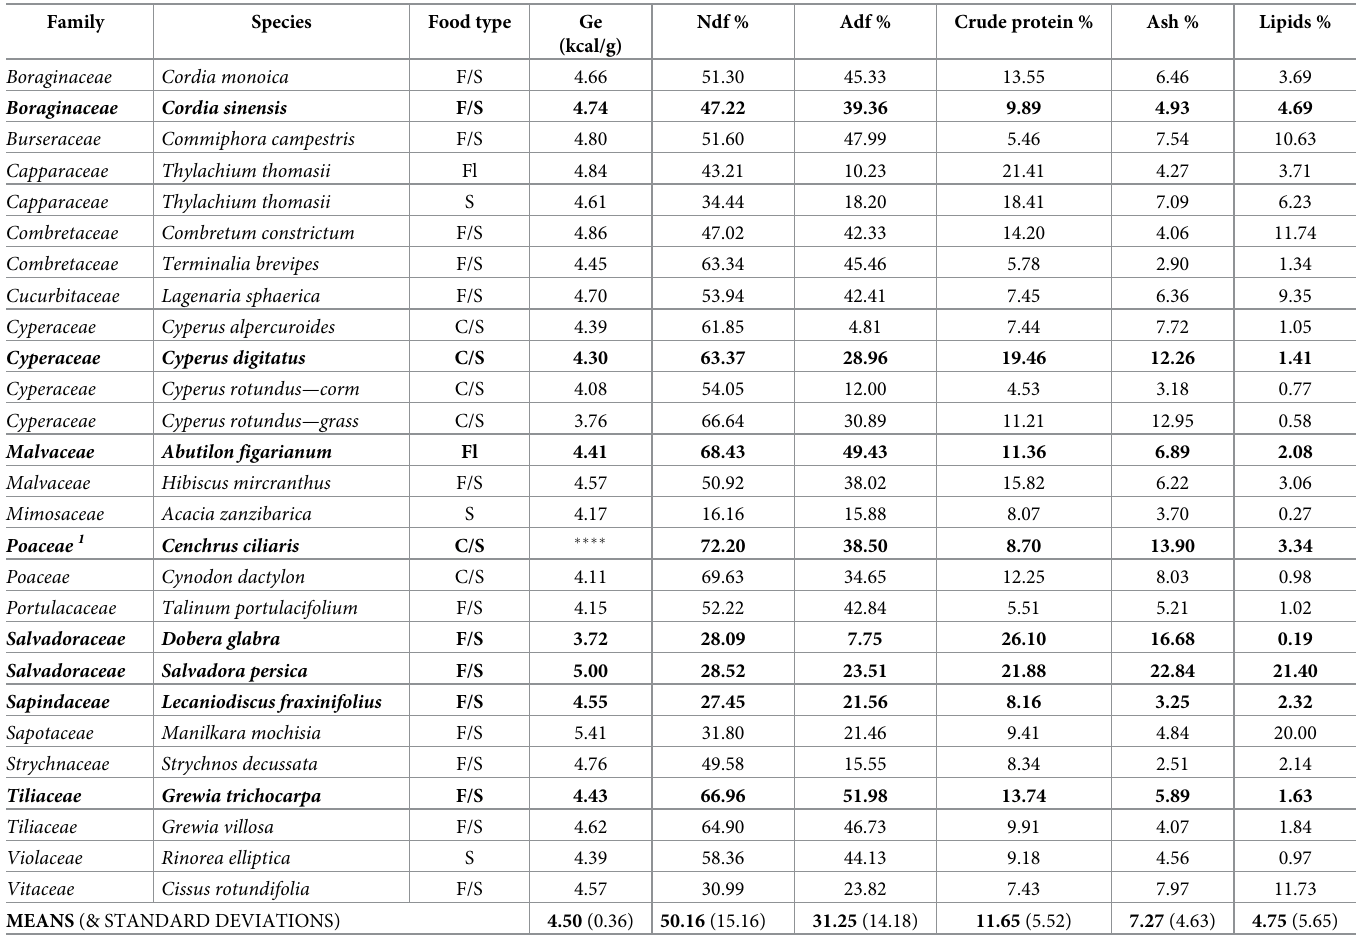
Table 2. Mchelelo baboon dietary macronutrient content (%DM)–savanna samples